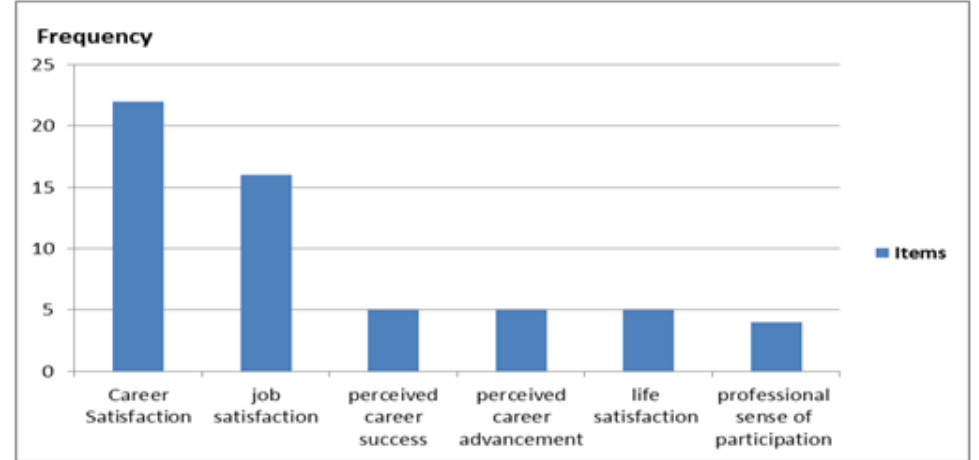
Figure 2. The evaluation index statistics of subjective career success from Arthur et al.